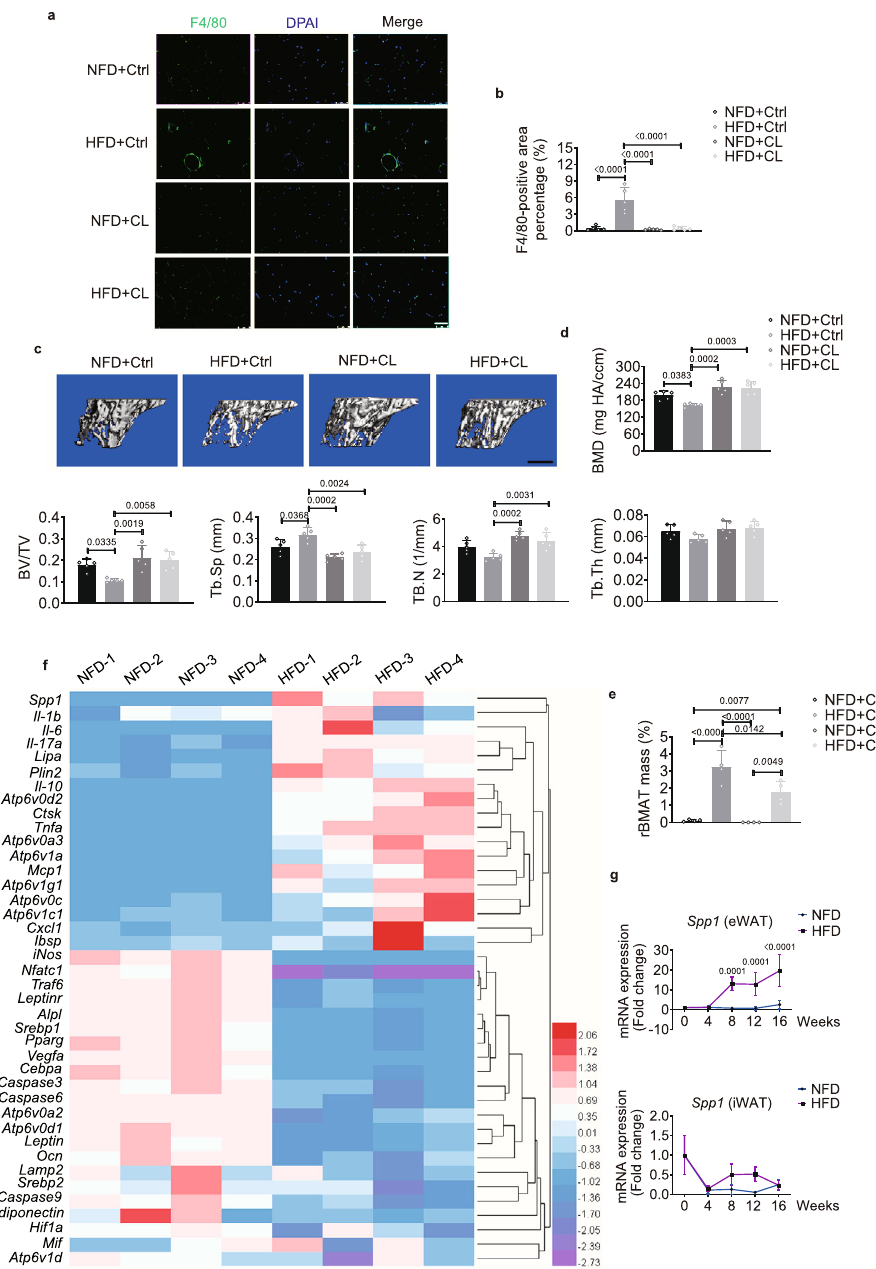
Fig. 4 In fi ltrating ATMs in eWAT are related to bone marrow metabolism. a Immuno fl uorescence staining of macrophages (F4/80) in eWAT after mice were injected with clodronate liposomes (CL) or control liposomes (Ctrl) into bilateral eWAT for 8 weeks. Green, F4/80; blue, DAPI stain for cell nuclei. Scale bar: 75 μ m. b Quanti fi cation of the F4/80-positive area percentage with immuno fl uorescence staining from A ( n = 5 biologically independent samples). c , d Representative μ CT image ( c ) and quanti fi cation ( n = 5 biologically independent samples) ( d ) of proximal tibiae after mice were